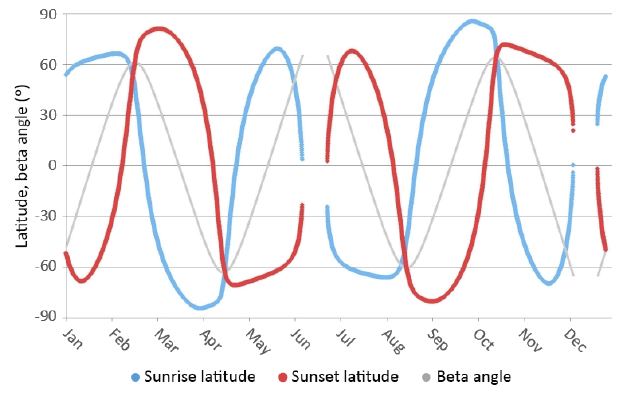
Figure 1. ACE measurement latitude for sunrise and sunset and beta angle as a function of time of year. For a brief time around each solstice ACE is unable to make measurements due to the position of its